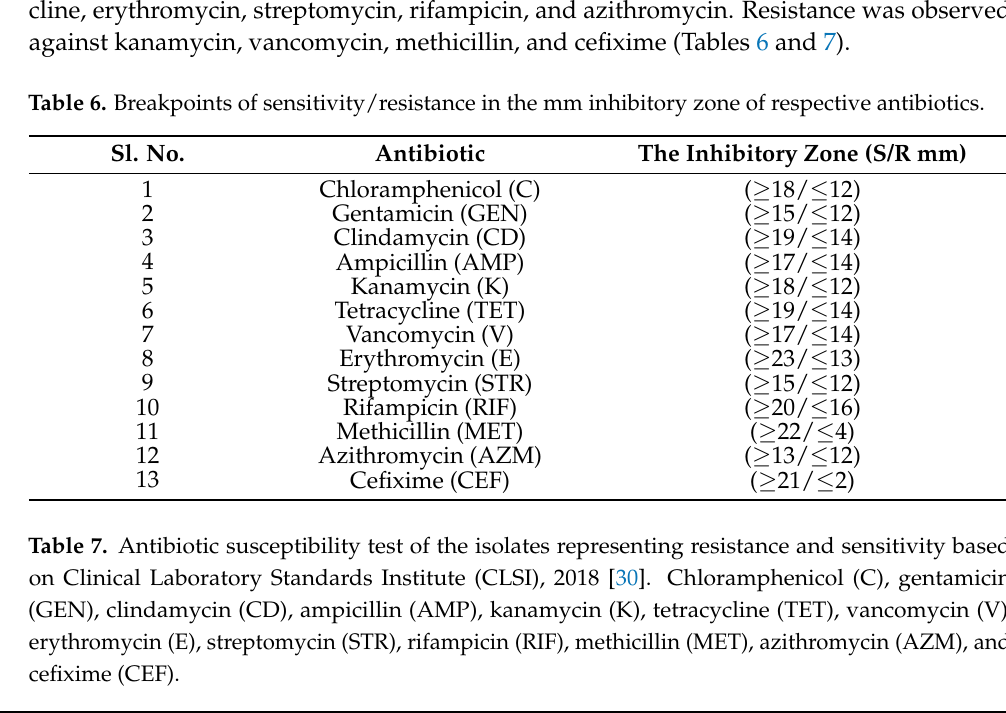
Table 7. Antibiotic susceptibility test of the isolates representing resistance and sensitivity based